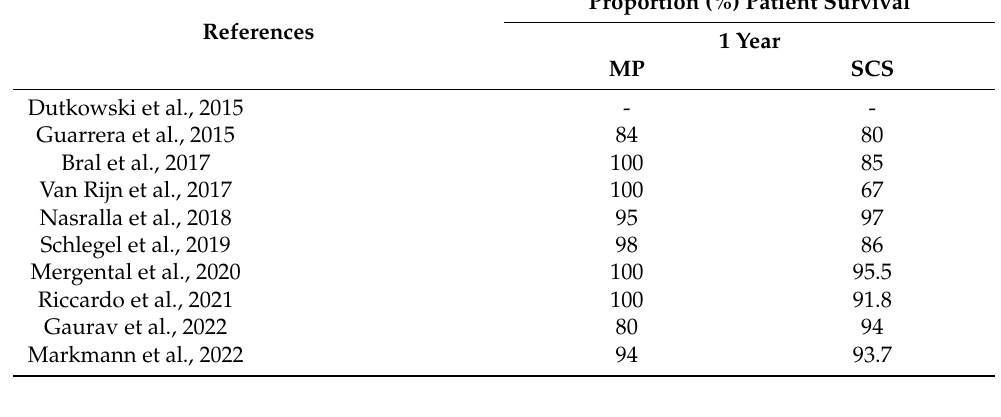
Table 5. Patient survival.